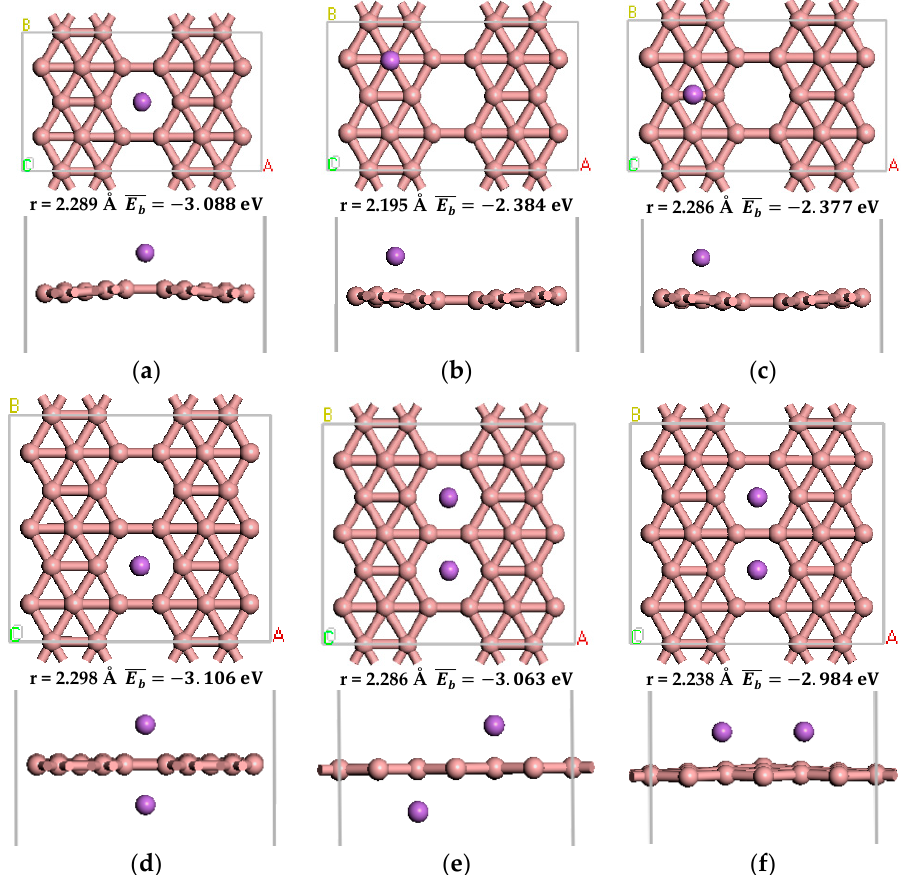
Figure 3. The optimized atomic structure of Li atom decorated β 12 -borophene. ( a – c ) show the one Li atom decorated single-sided β 12 -borophene, respectively. ( d – f ) show the two Li atoms decorated double-sided β 12 -borophene, respectively.